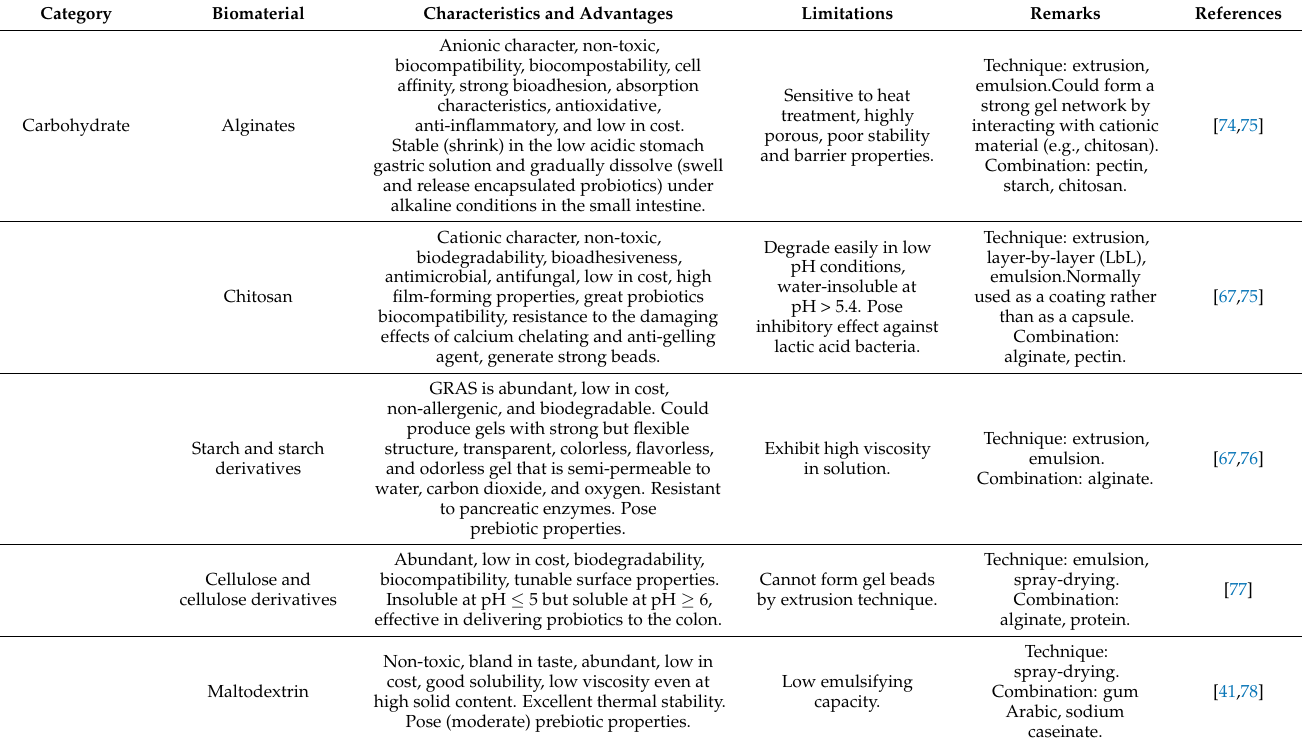
Table 2. Common biomaterials for encapsulating